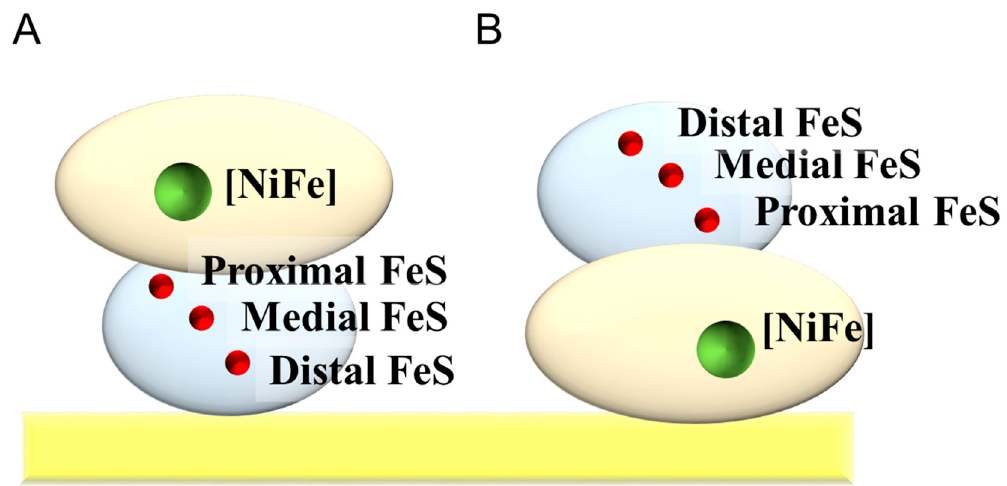
Figure 7. Schematic illustrations for the adsorbed H 2 ase on a flat electrode in (A) effective and (B) B ) invalid orientations for the DET-type invalid orientations for the DET-type bioelectrocatalysis. (